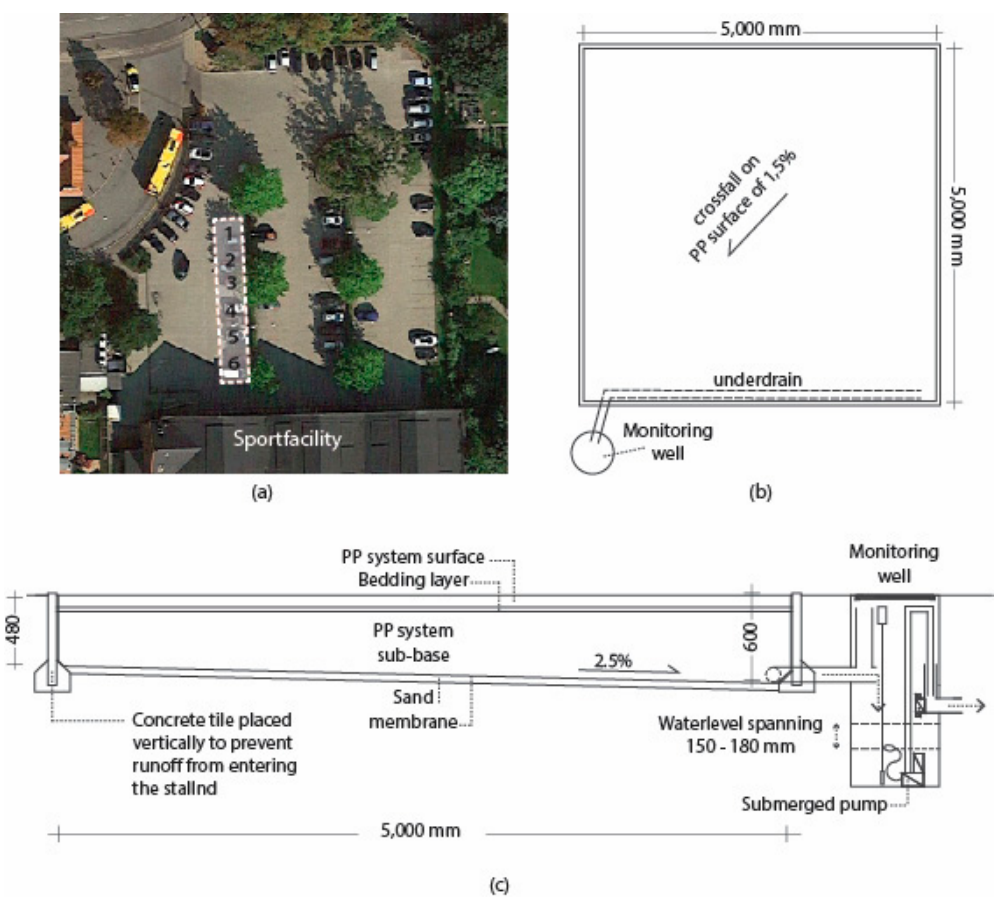
Figure 1. Location and construction of the six experimental stalls of lined PP-systems with: ( a ) an aerial photo of the parking area with position of stalls marked; ( b ) diagram of an individual stall; and ( c ) a cross-section of individual stall and monitoring well.